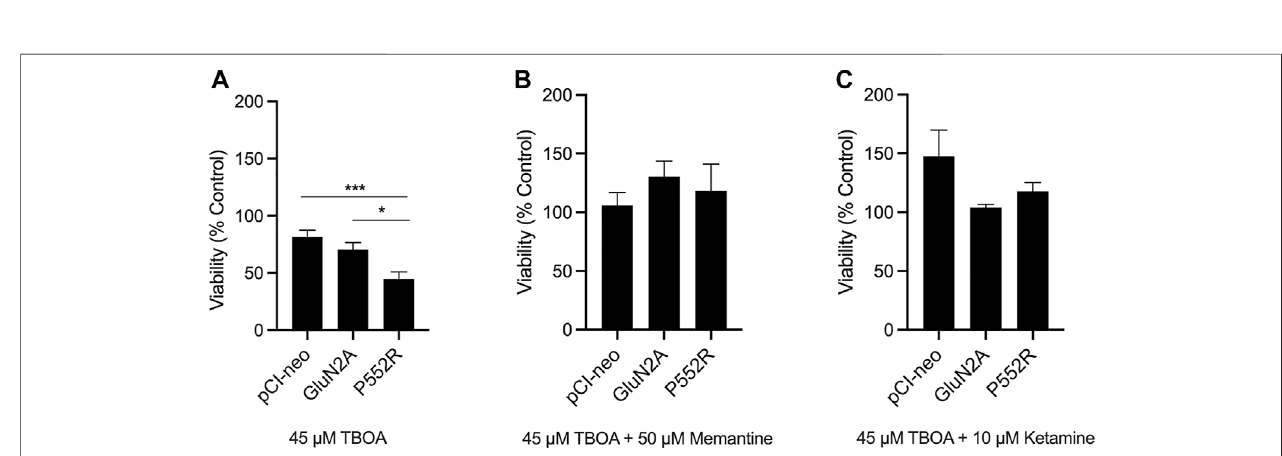
FIGURE4| GluN2A-P552Renhancesvulnerabilitytoexcitotoxicstresswhichcanberescuedbybothmemantineandketamine.Luciferaseassayswereusedasa measure of cell viability. Rat cortical neurons were co-transfected with a plasmid expressing fi re fl y luciferase and pCI-neo vector, GluN2A-WT, or GluN2A-P552R. Treatments were applied 24 h after transfection and luciferase assays were performed 48 h following transfection. Neurons expressing GluN2A-P552R showed signi fi cantly reduced viability after exposure to 45 µM TBOA as compared to those expressing the empty vector or wild-type receptor (A) (* p < 0.05, *** p < 0.001, one-way ANOVA/Tukey post-hoc, n (cid:2) 8). However, this reduction in viability was rescued by co-treatment with 50 µM memantine (B) (one-way ANOVA, p > 0.05) or 10 µM ketamine (C) (one-way ANOVA, p > 0.05). Luciferase values for TBOA treated neurons were normalized to their relevant vehicle-treated vector group. Data represent mean ± SEM from 4-8 independent experiments performed in triplicate or